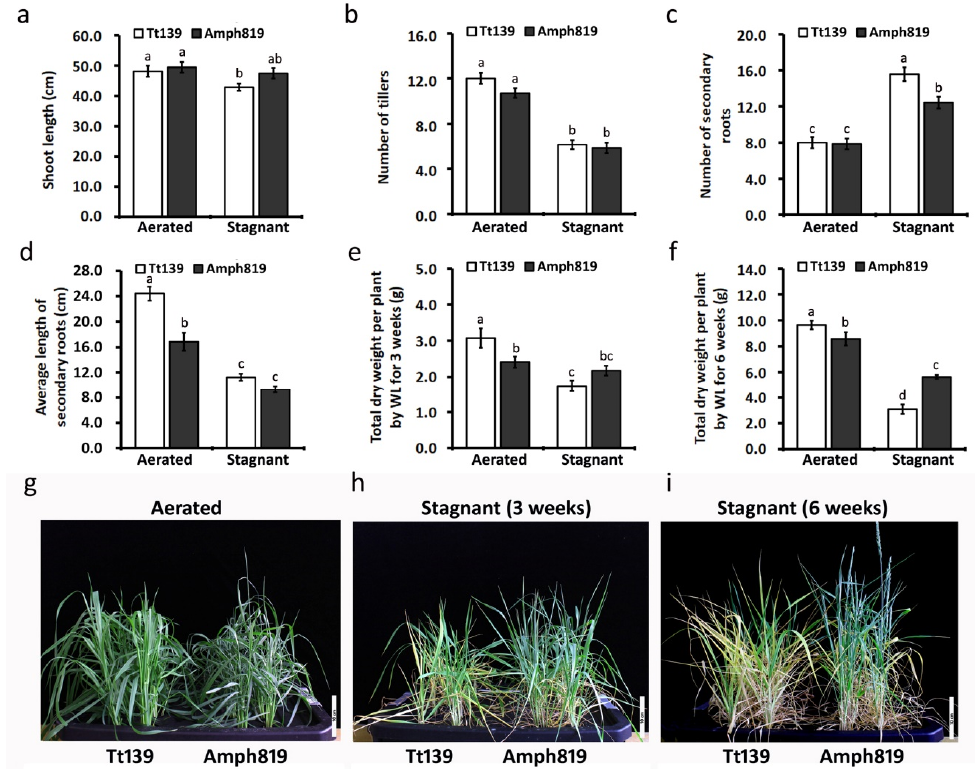
Figure 1. Plant growth and phenotypes of Tt139 and Amph819 seedlings under aerated and stagnant conditions. ( a – d ) Shoot length ( a ), the number of tillers ( b ), the number of secondary roots ( c ) per plant, and the average length of secondary roots ( d ) were measured from Tt139 and Amph819 seedlings under aerated and stagnant conditions 3 weeks after treatment. ( e , f ) The dry mass of Tt139 and Amph819 seedlings grown in aerated or stagnant conditions for 3 weeks ( e ) and 6 weeks ( f ), respectively. Values are means ± SE ( n = 8). Letters indicate significant differences between means, determined using Duncan’s multiple range test (5% α ). ( g – i ) The phenotypes of Tt139 and Amph819 grown in aerated condition ( g ) and stagnant condition for 3 weeks ( h ) and 6 weeks ( i